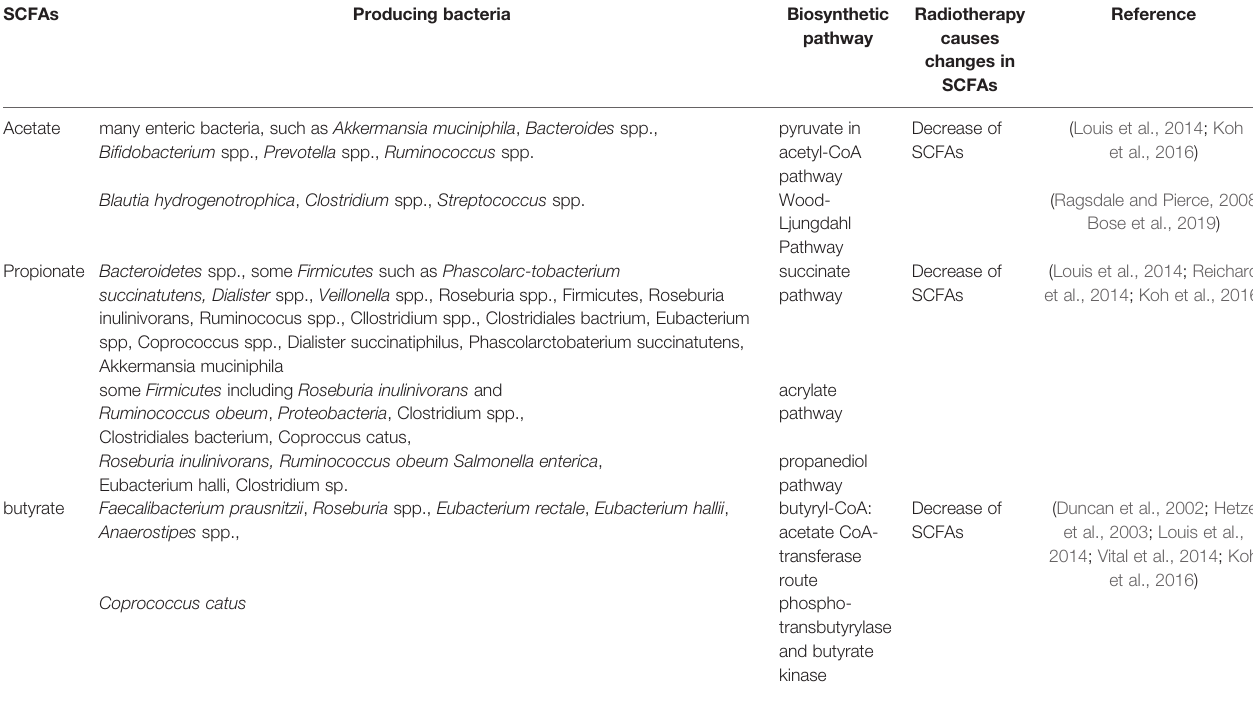
TABLE 2 | The production of SCFAs and changes after